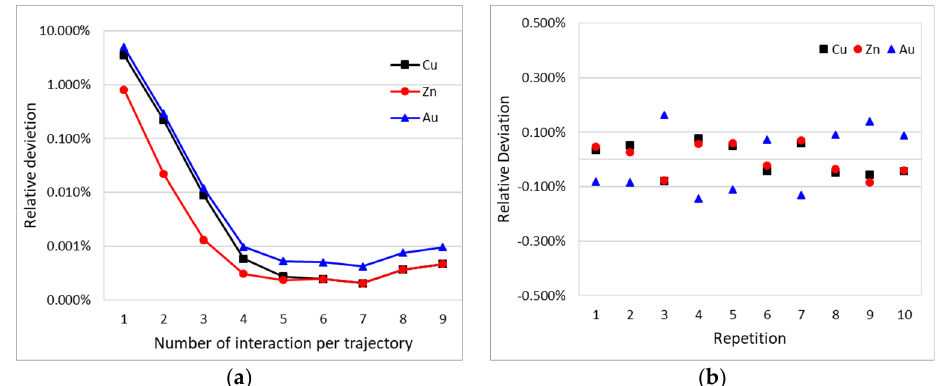
Figure 2. PRs of Cu, Zn, and Au of a simulated 1 µ m of gold coating on brass substrates: ( a ) relative deviation of the PRs increasing the number of interactions respect to the simulation with 10 interactions; ( b ) relative deviation from the mean value repeating the same simulation10 times.